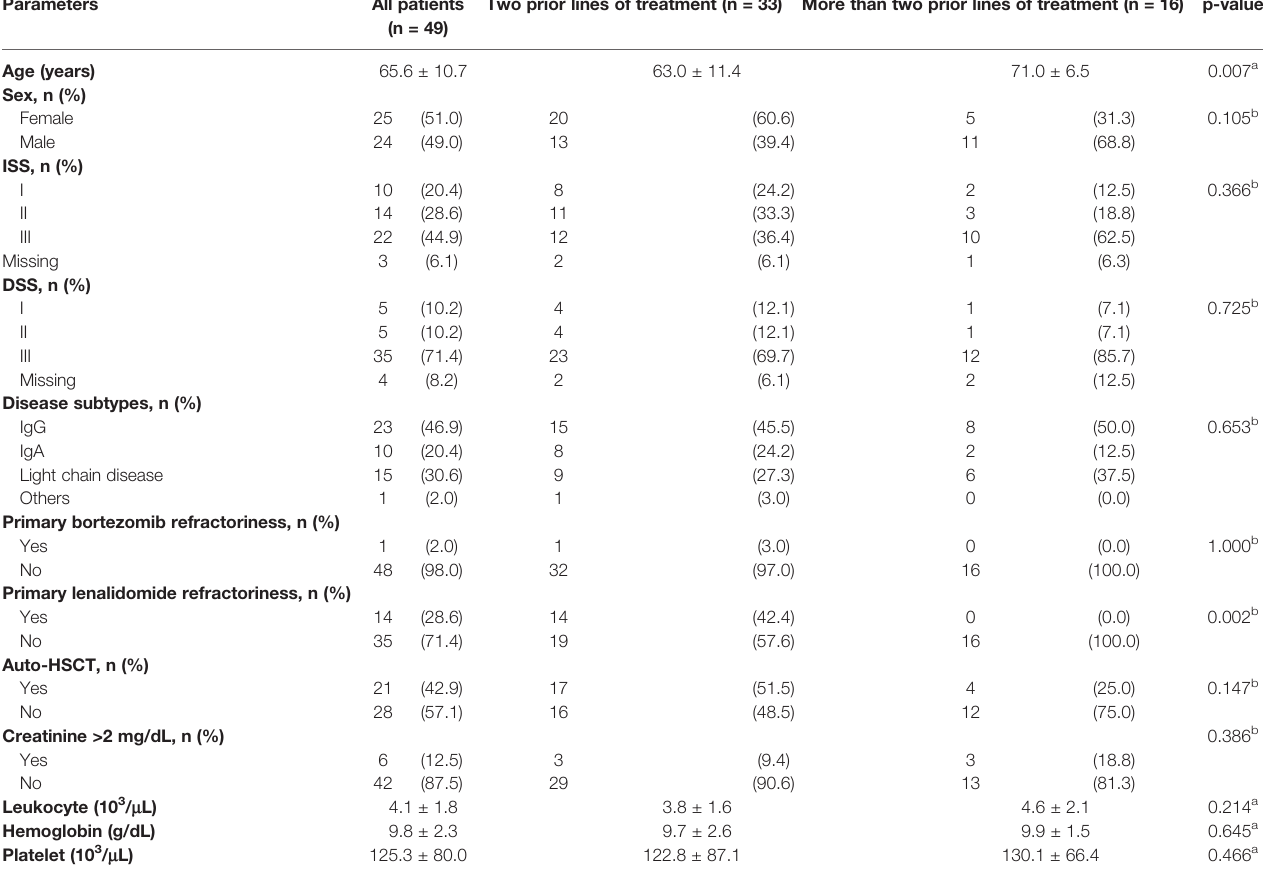
TABLE 1 | Clinical characteristics of patients undergoing Pom/Dex treatment. Parameters